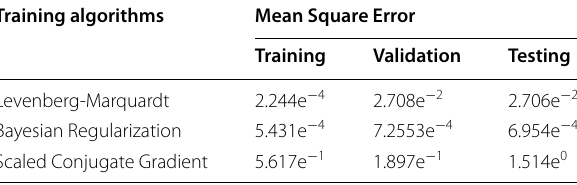
Table 1 Comparison of the effect of different BP training Training algorithms Mean Square Error Training Validation